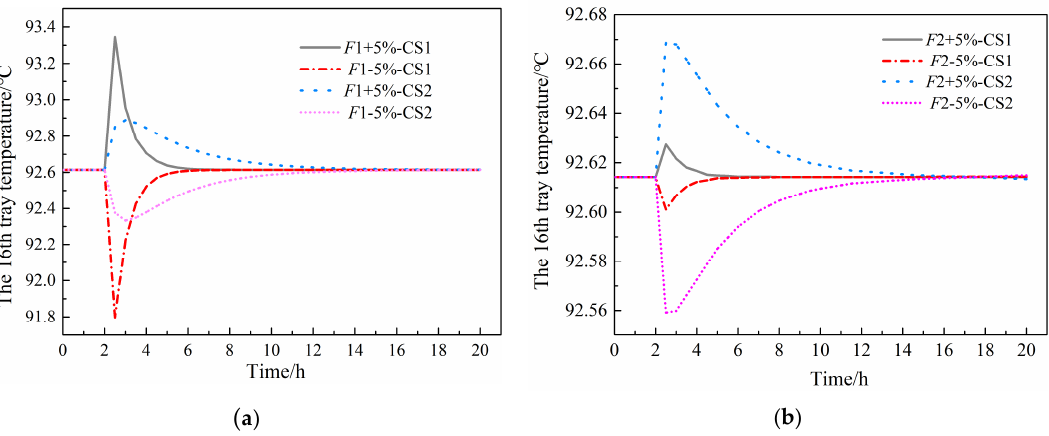
Figure 10. The control responses of CS1 and CS2 on the temperature of the 16th try. ( a ) Responses to disturbance in feed F1 and ( b ) responses to disturbance in feed F2.